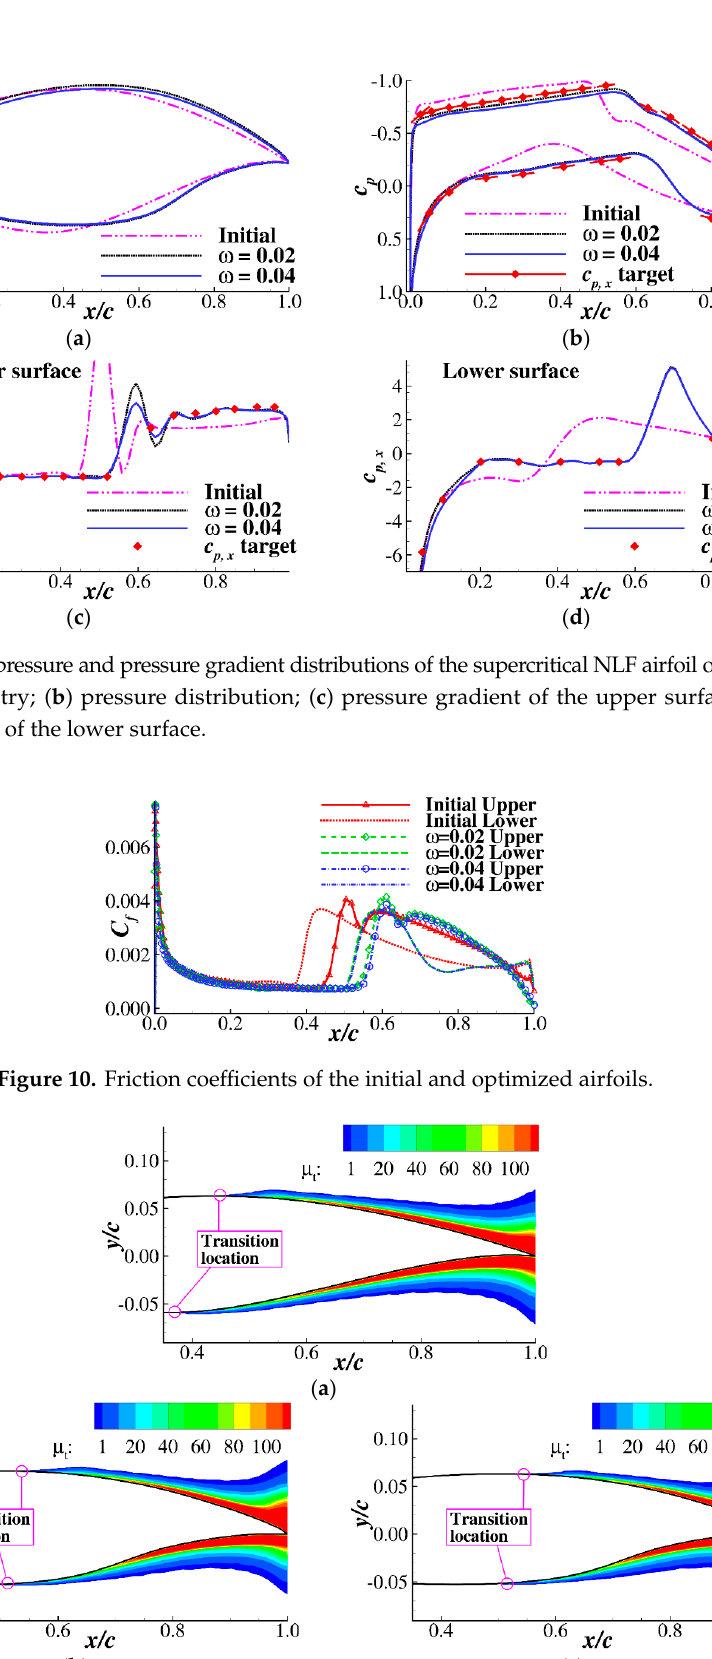
Figure 10. Friction coefficients of the initial and optimized airfoils.